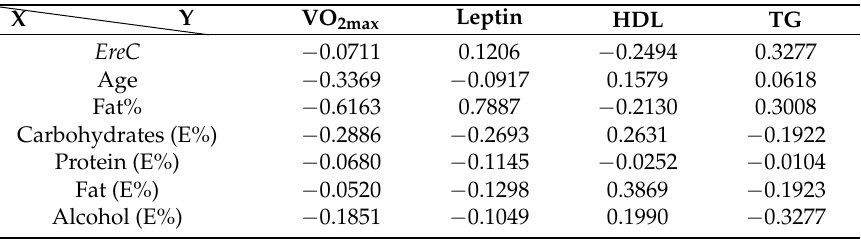
Table 3. The regression weights of multivariable associations.